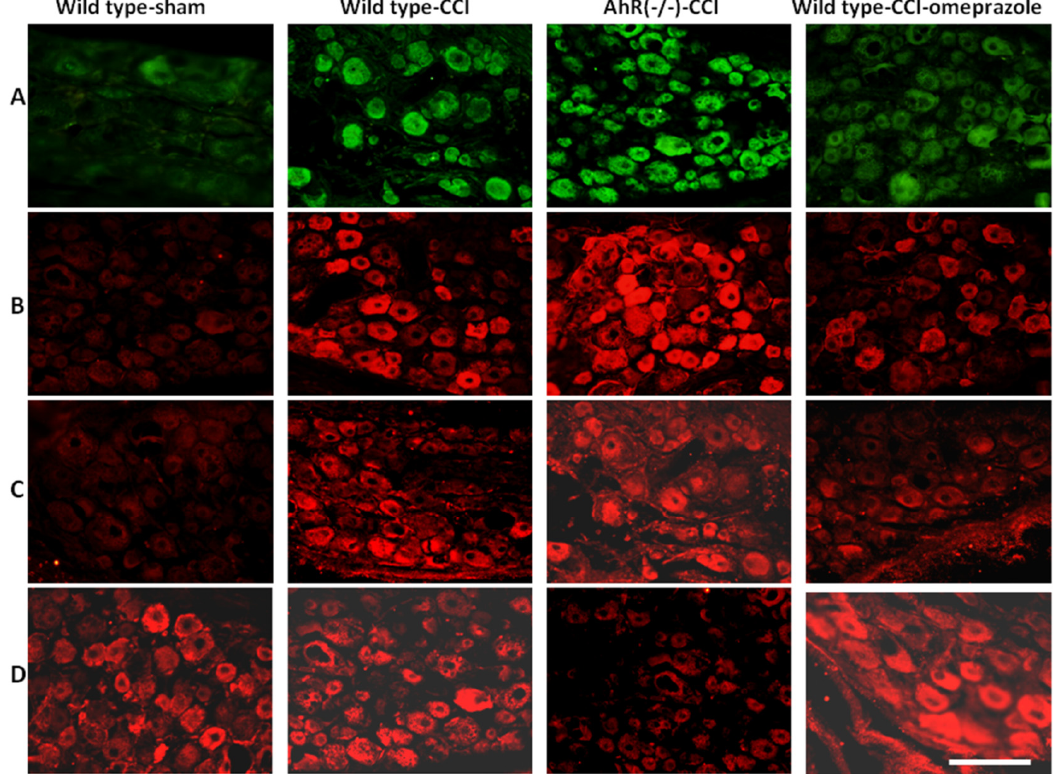
Figure 8. The alteration of the inflammatory response and AhR over the spinal dorsal root ganglion in a CCI model modulated by AhR. Either wild or AhR-deleted mouse received CCI injuries and then were subjected to omeprazole treatment. The dorsal root ganglion was obtained for the analysis 28 days after CCI. ( A ) Expression of NGF in the different treatment groups. ( B ) Expression of TNF- α in the different treatment groups. ( C ) Expression of synaptophysin in the different treatment groups. ( D ) Expression of AhR in the different treatment groups. Bar length = 100 μ m; N = 6; Wild type-sham; Table 3. Expression of the inflammatory proteins in the dorsal root ganglion. Wild Type-